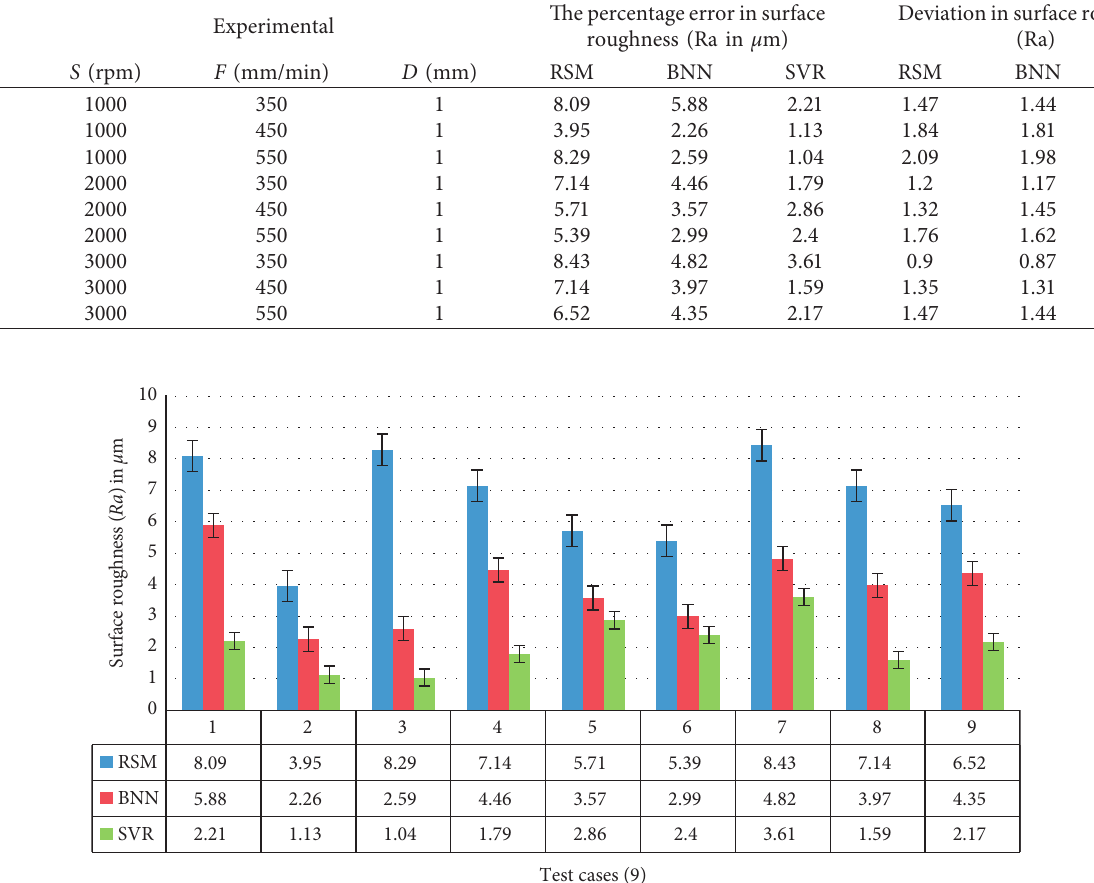
Figure 12: The predicted percentage of error for Ra among prediction models.